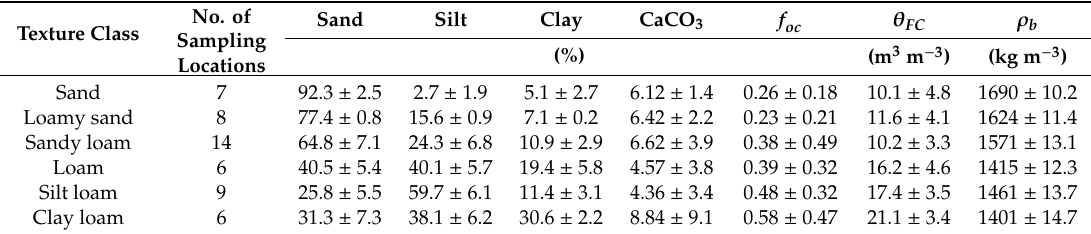
Table 2. Basic soil properties of the soil samples collected from the study area in Jazan watershed. Texture